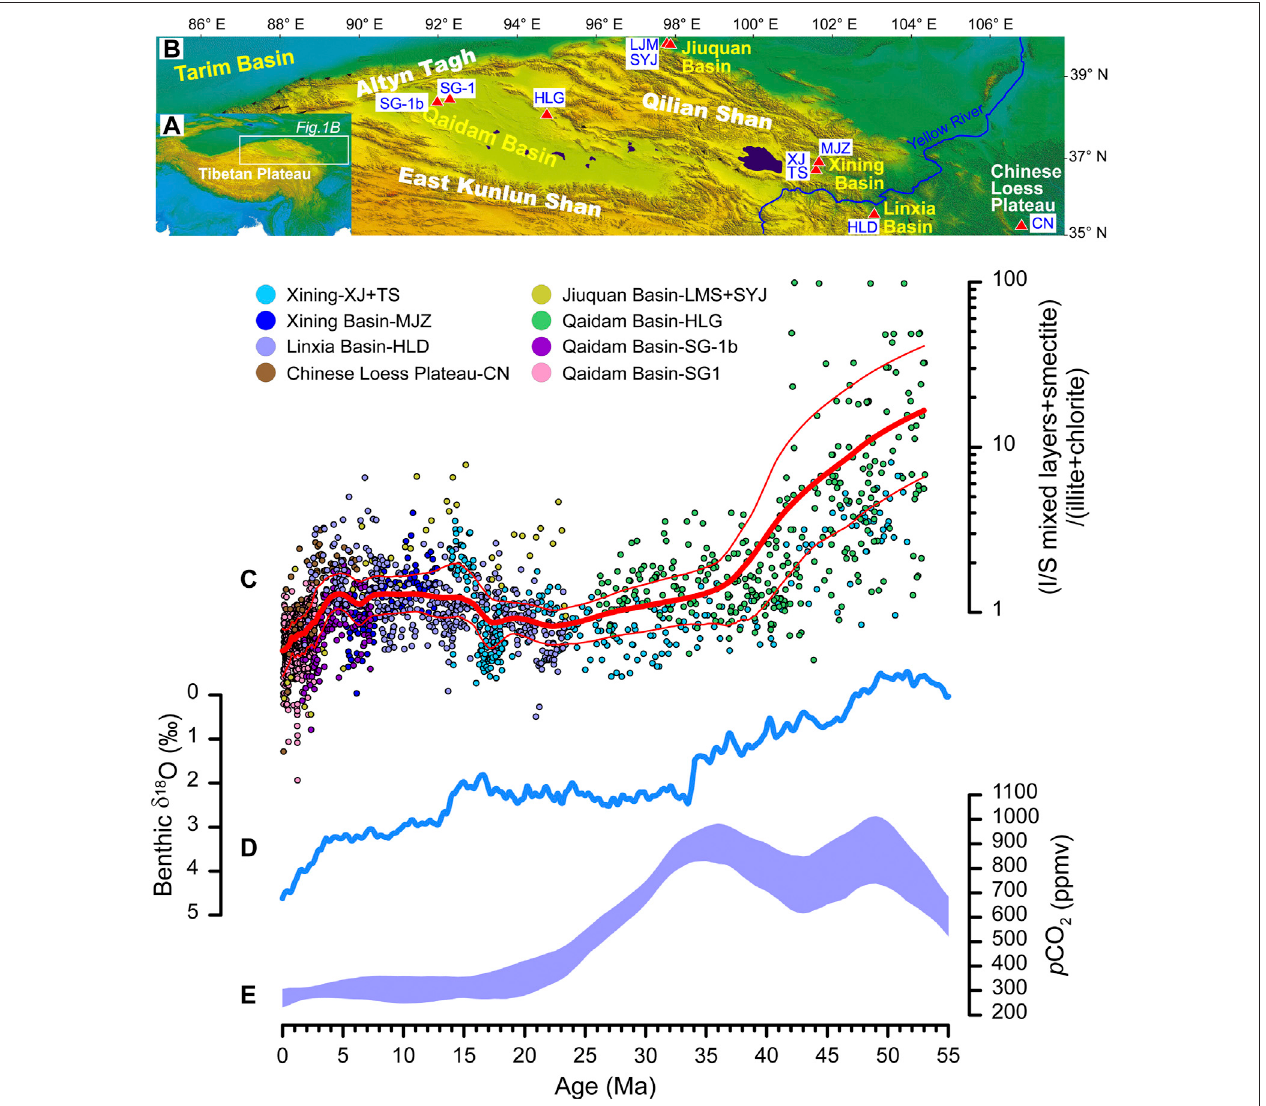
FIGURE1| CenozoicsilicateweatheringhistoryintheNETibetanPlateau (A-B) MapoftheNETibetanPlateaushowingsitelocations (C) Compiled(I/Smixedlayer + smectite)/(illite+ chlorite) ratiofrom the ten studied sections. The red lines show the results oflocally-weighted scatterplot smoothing (LOWESS, smoothing factor 0.1) andthecorrespondinguncertaintyenvelope (D) Benthicoxygenisotoperecord(Westerholdetal.,2020) (E) Proxy-basedatmosphericCO 2 content(Fosteretal.,2017).